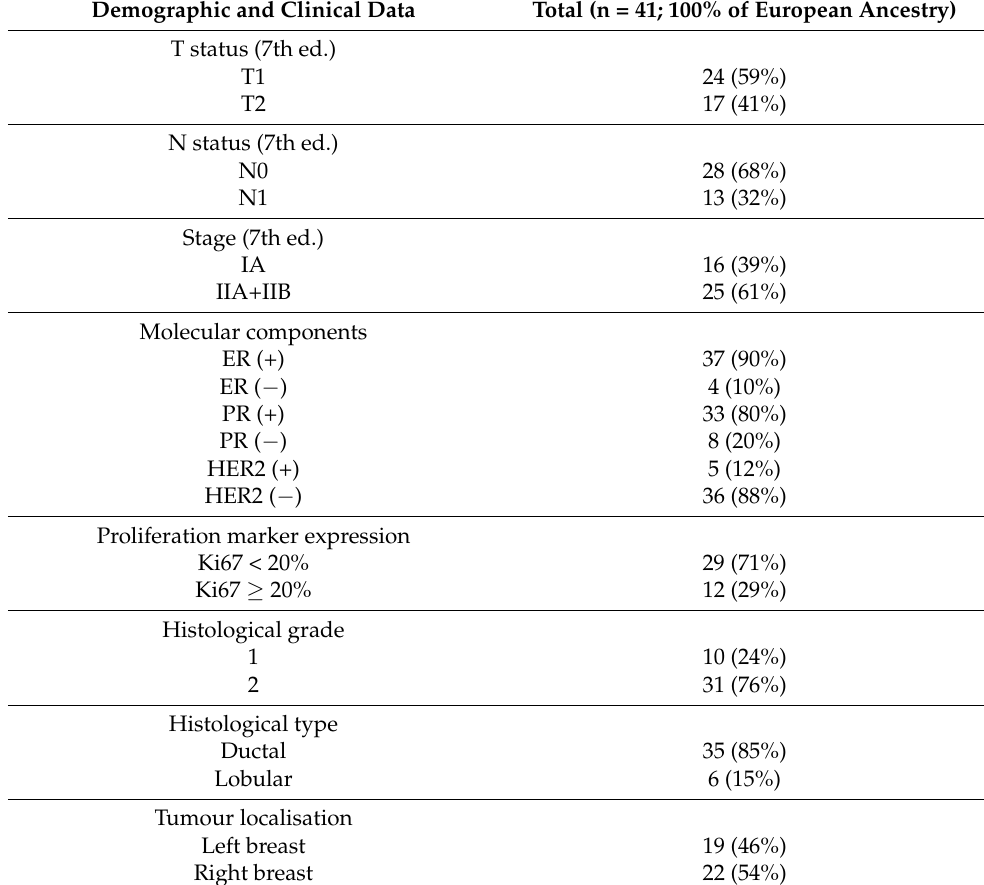
Table 1. Cont . Demographic and Clinical